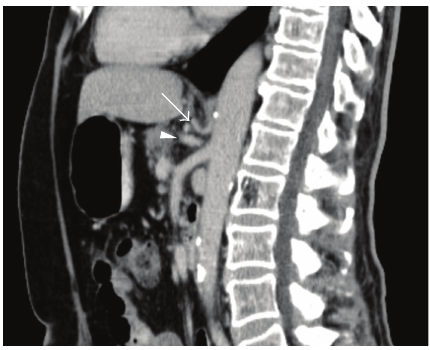
Figure 3: Sagittal CT scan image demonstrating the supra-dia- phragmatic origin of the left gastric artery (arrow) and the separate celiac origin (arrowhead). Aortic atherosclerotic calcifications can also be